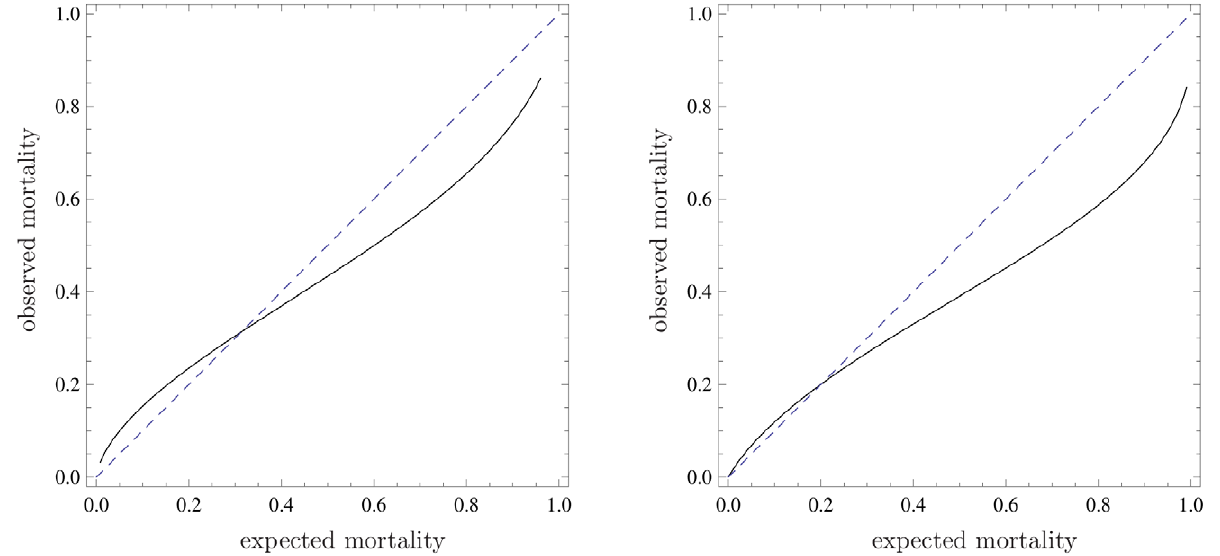
Figure 2. Calibration functions ( solidline ) compared to the bisector ( dashedline ) for the two discussed examples. The stopping criterion yielded m f ~ 1 for the left curve and m f ~ 2 for the right one. To avoid extrapolation the curve have been plotted in the range of mortality where data are present. Refer to the caption of Fig. 1 for information about the data sets.